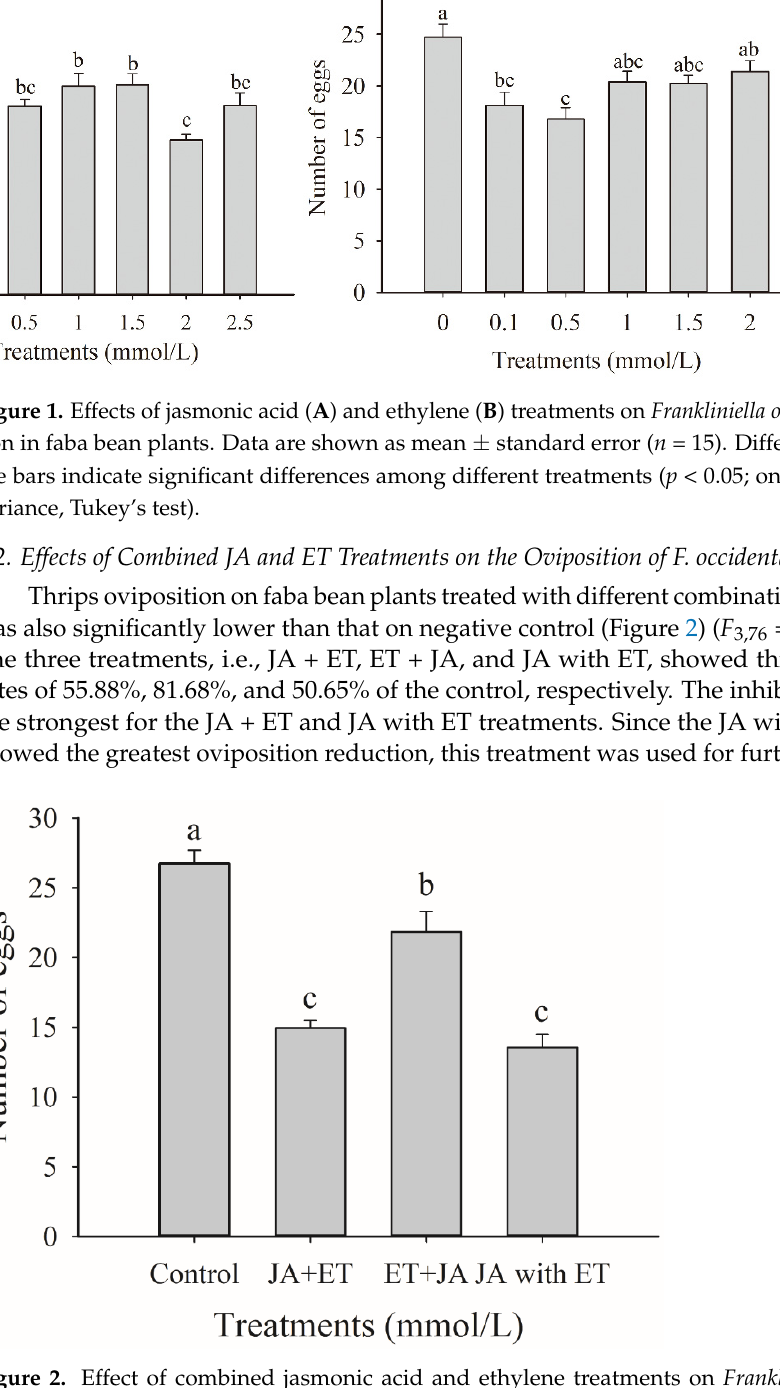
Figure 2. Effect of combined jasmonic acid and ethylene treatments on Frankliniella occidentalis oviposition in faba bean plants. Data are presented as mean ± standard error ( n = 20). Different letters above the bars indicate significant differences among different treatment amounts ( p < 0.05; one-way analysis of variance, Tukey’s test).